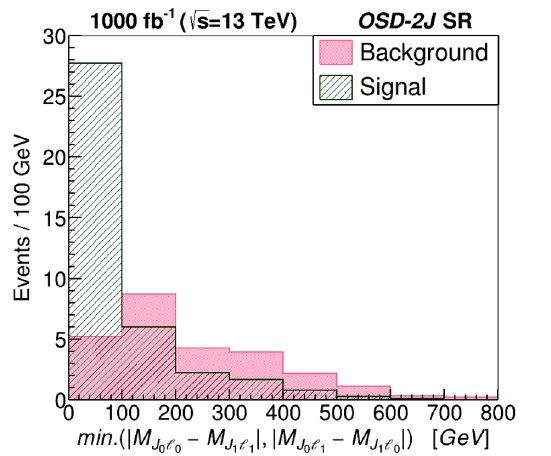
Figure 8 . Distributions of the difference between the two lepton-fat-jet invariant masses for the OSD-2J SR for BP1 : M χ = 1 TeV and BR ( χ ± → νW ± ) ≈ 50% in Model- 3 F weighted for 1000 fb − 1 at the 13 TeV LHC.